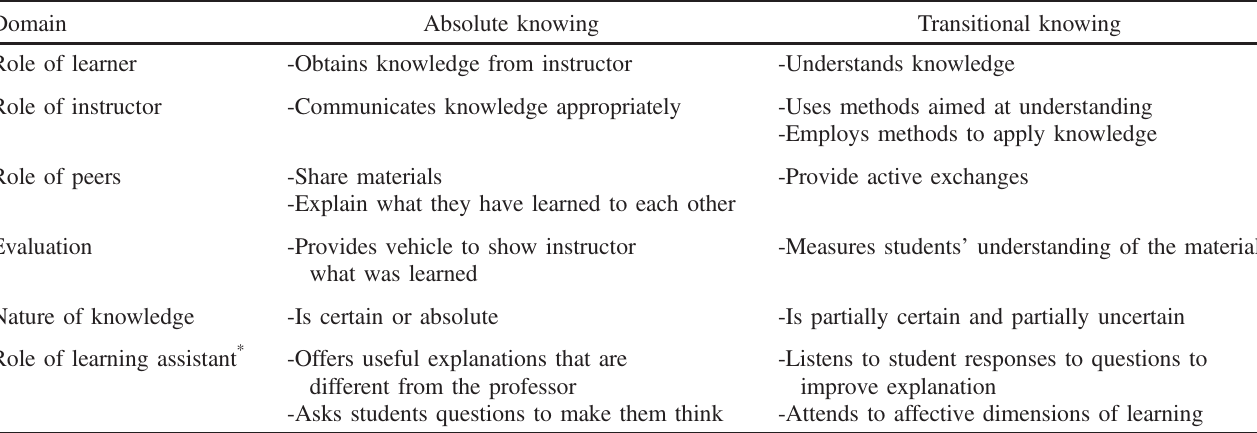
TABLE I. Overview of absolute and transitional ways of knowing within the epistemological reflection model.